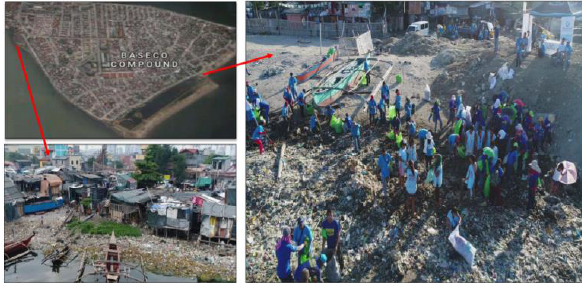
Figure 11 . Drone inspections at trash accumulation points in the BASECO area.